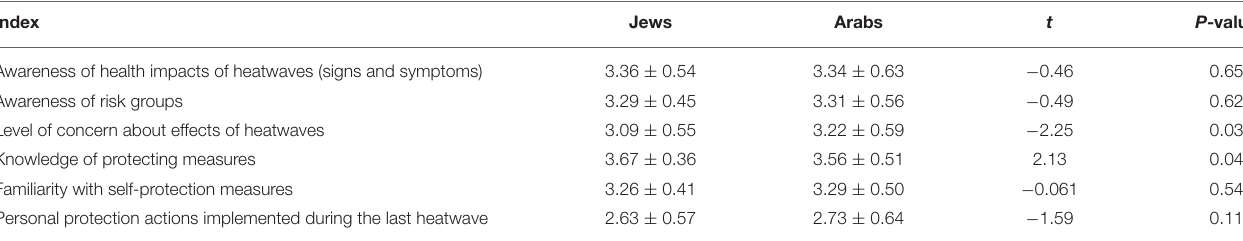
TABLE 2 | Index differences between population